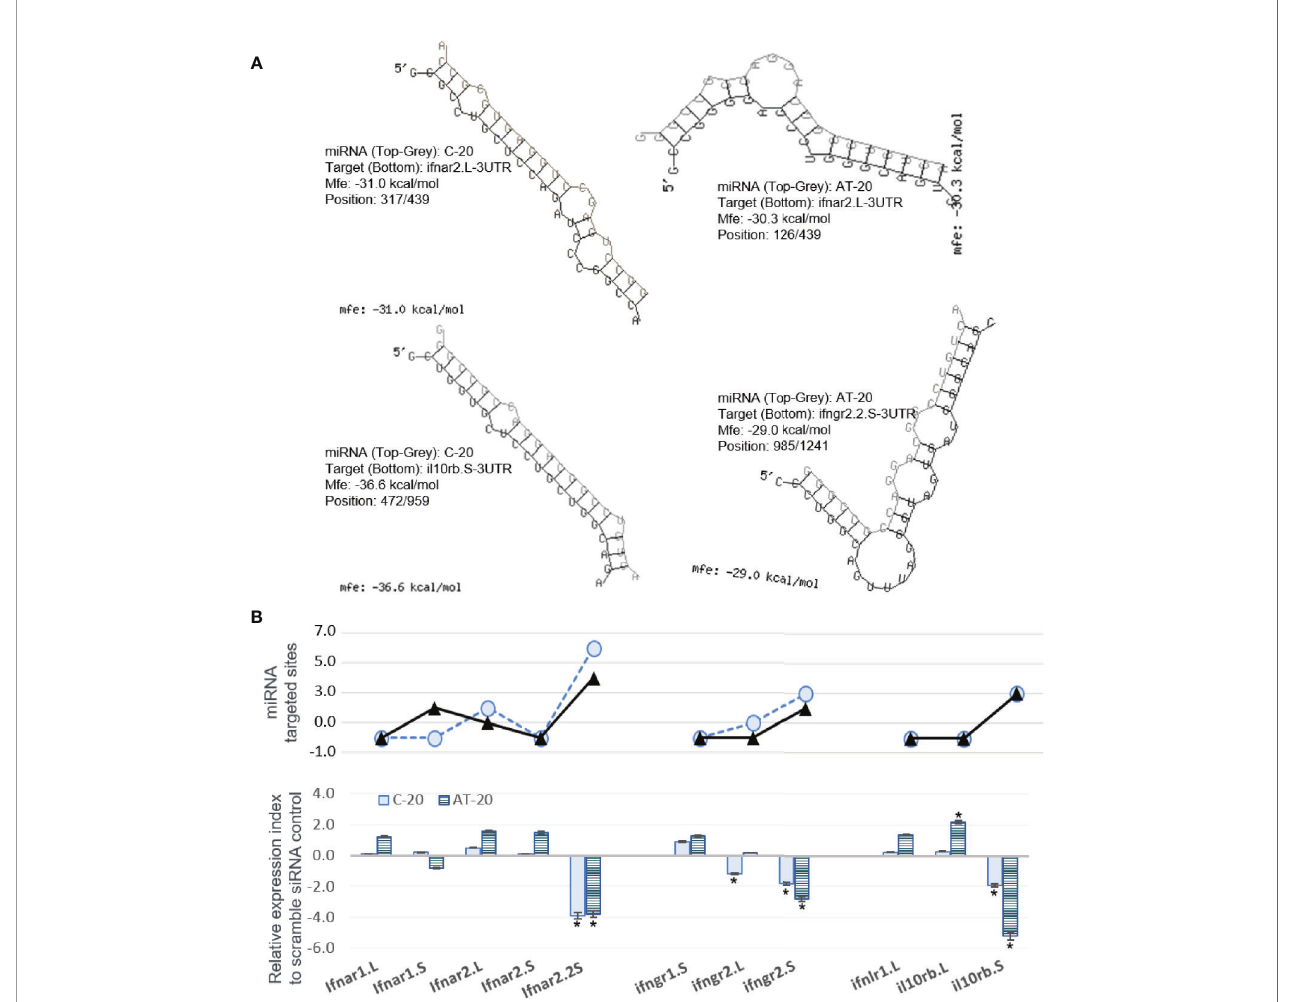
FIGURE 10 | Examples of miRNA that are predictably targeted on 3 ’ -UTR regions of Xenopus mRNA encoding interferon receptor subunits. (A) Hybridization of individual miRNA with its mRNA targets was performed using a program of RNAhybrid with its accompanying programs RNAcalibrate and RNAeffective as described. The hybridization structures and minimum free energy (Mfe) are given, the thresholds of Mfe was set as -28.0 kcal/mol to re fl ect typical Mfe of miRNA (like let7 ) hybridization to mRNA targets. MiRNA C-20 or AT-20, the twentieth miRNA in the C or AT groups, respectively, as illustrated in Figure 2 and Supplement Excel sheet for sequence detail. (B) Functional validation using synthetic siRNA with identical sequences to the mature C-20 and AT-20 miRNAs. Synthesis of siRNAs and transfection of X. laevis A6 cells were performed as described, and gene speci fi c RT-PCR was used to quantify the expression of target genes. Top panel : Line chart representing numbers of predicted sites targeted by miRNA on the 3 ’ -UTR of each template target. Bottom panel : Bar chart of relative gene expression obtained with mature C-20 (gray histogram) and AT-20 (hachured histogram) miRNAs. The GenBank Accession numbers of the tested transcripts are listed in Table 2 . *p < 0.05, n = 5 relative to the sample transfected using a scramble